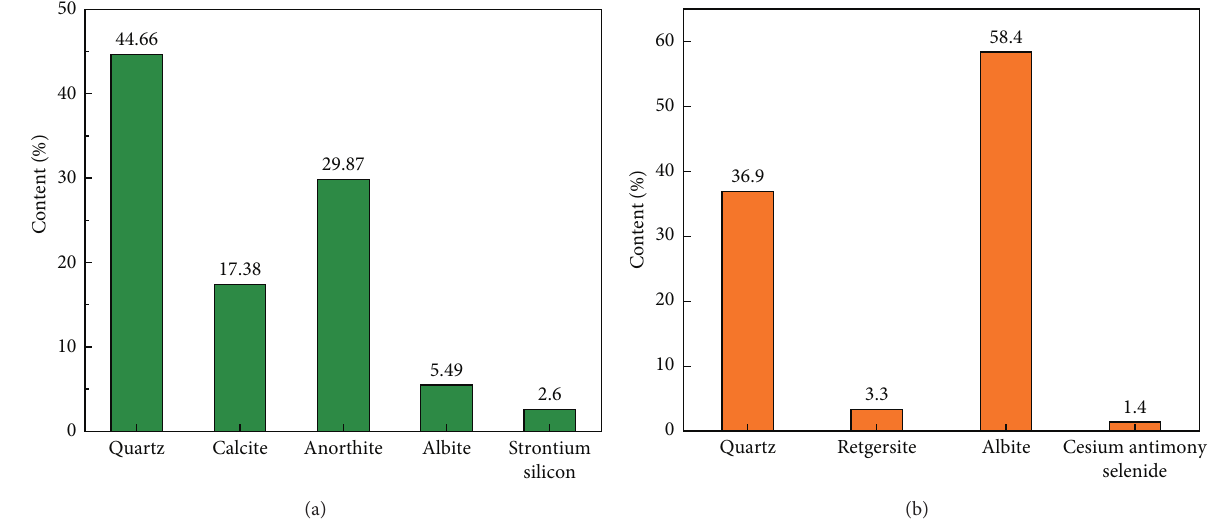
Figure 4: Mineral compositions of test soils. (a) Loess. (b) Sand.